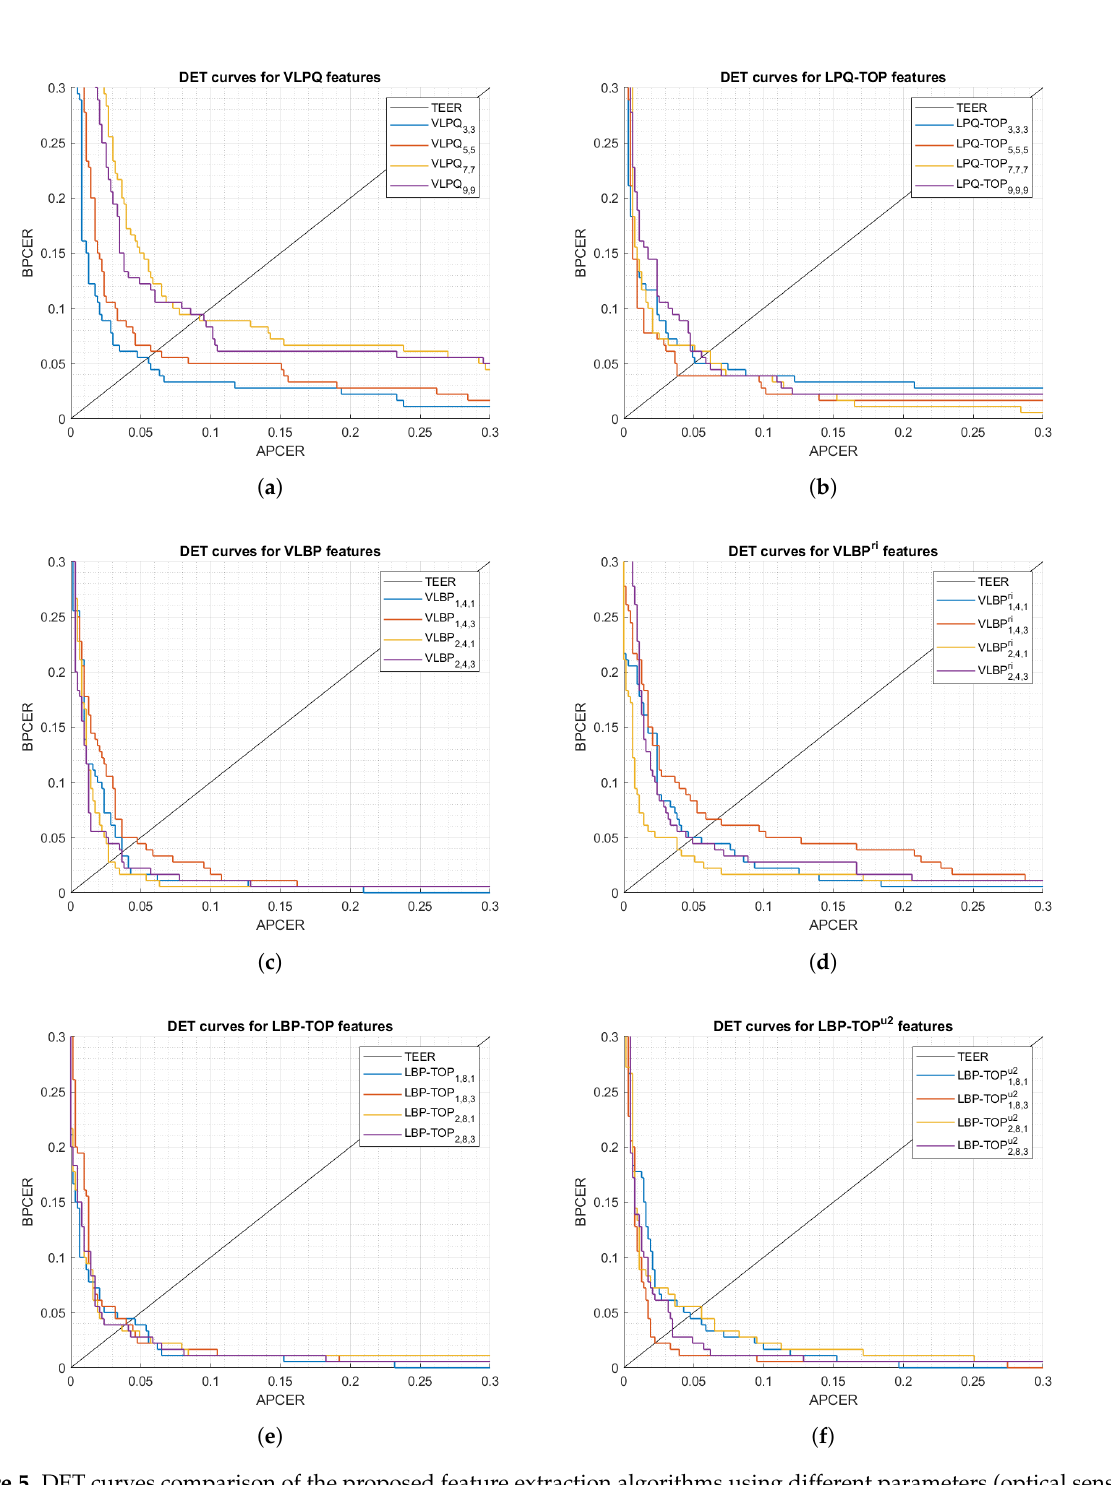
Figure 5. DET curves comparison of the proposed feature extraction algorithms using different parameters (optical